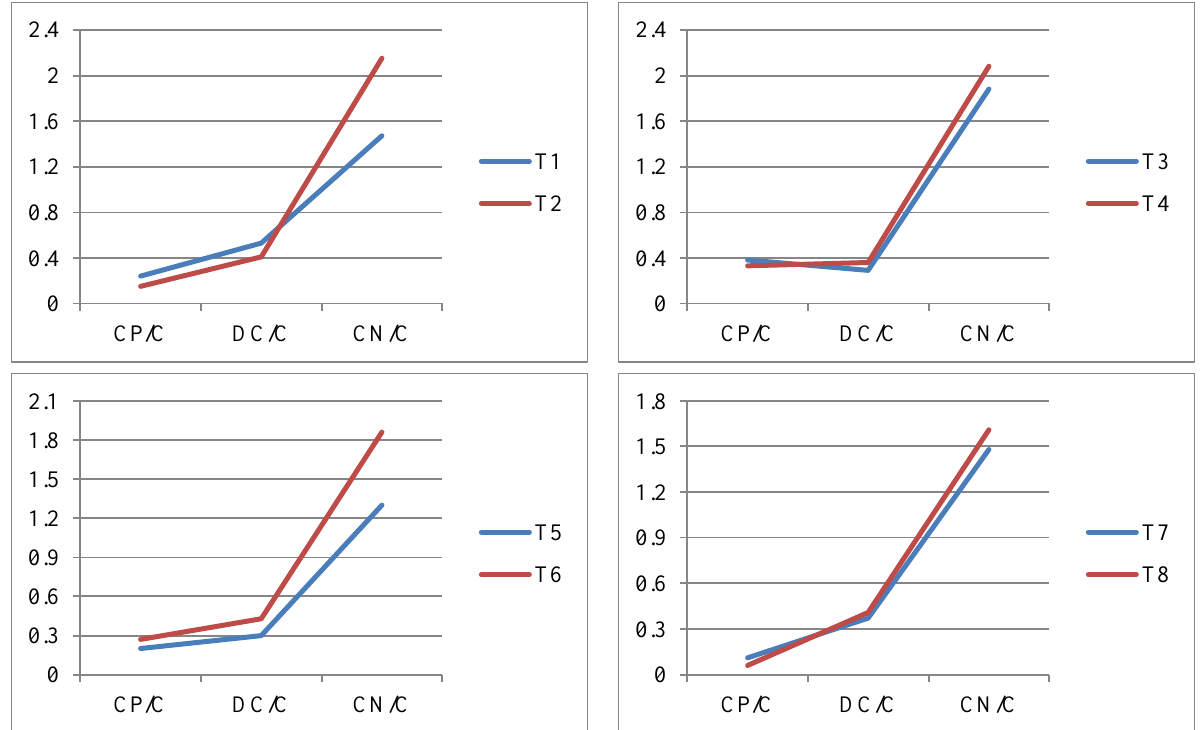
Results of Lexical Complexity